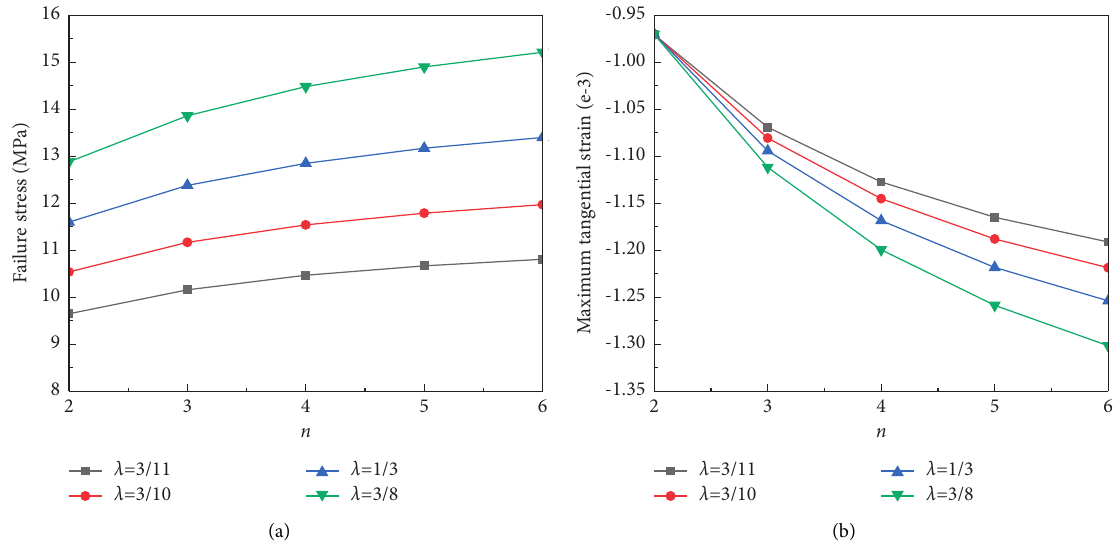
Figure 15: Variations in ultimate bearing capacity and maximum tangential strain with the number of layers n . (a) Ultimate bearing capacity. (b) Maximum tangential